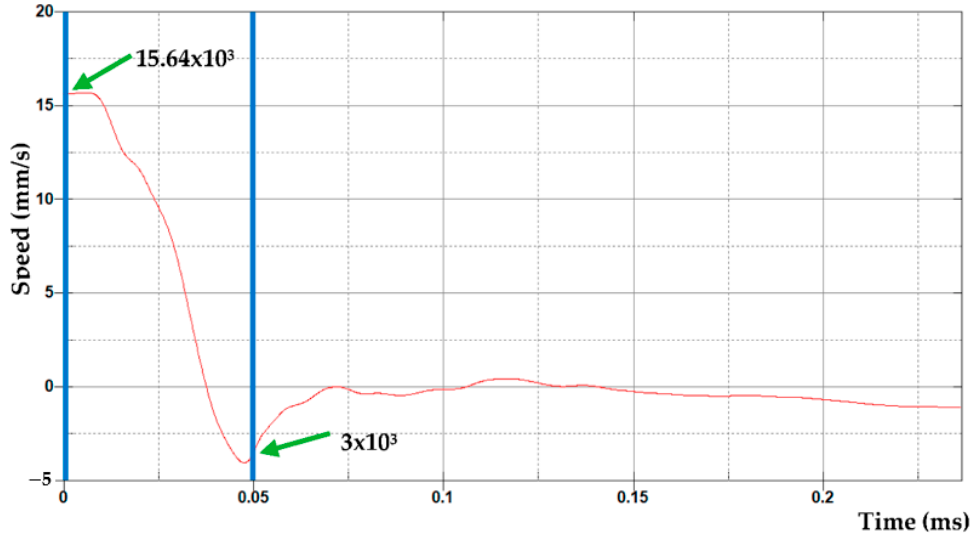
Figure 7. Behavior speed of the armored vehicle in the X -axis.